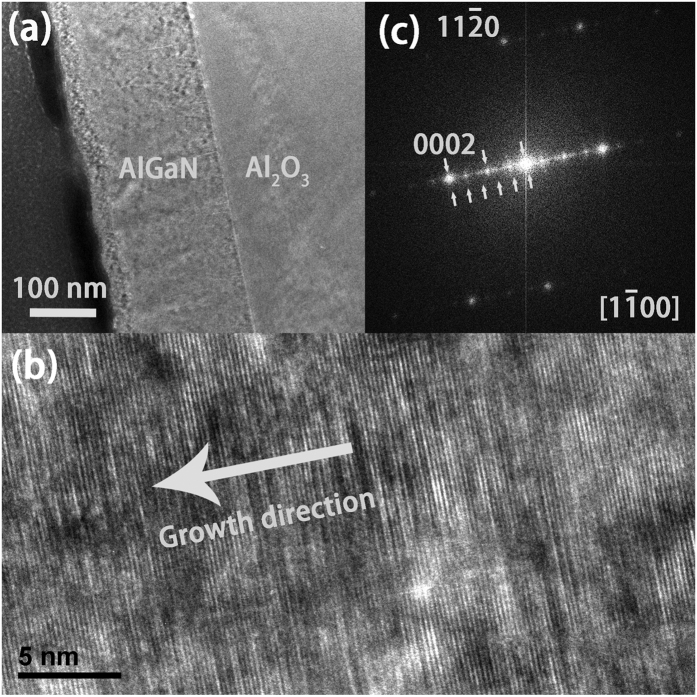
(a) Cross-sectional HRTEM image of AlGaN/Al2O3 in sample D5. (b) The magnified HRTEM image of AlGaN superlattices in sample D5. (c) FFT image of (b).